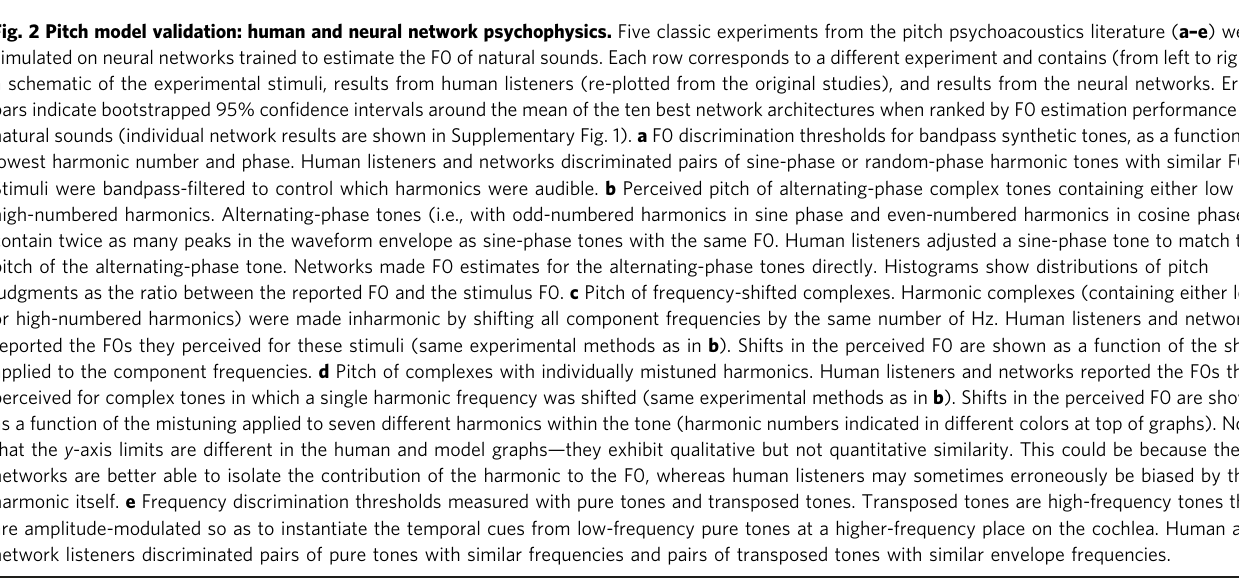
Fig. 2 Pitch model validation: human and neural network psychophysics. Five classic experiments from the pitch psychoacoustics literature ( a – e ) were simulated on neural networks trained to estimate the F0 of natural sounds. Each row corresponds to a different experiment and contains (from left to right) a schematic of the experimental stimuli, results from human listeners (re-plotted from the original studies), and results from the neural networks. Error bars indicate bootstrapped 95% con fi dence intervals around the mean of the ten best network architectures when ranked by F0 estimation performance on natural sounds (individual network results are shown in Supplementary Fig. 1). a F0 discrimination thresholds for bandpass synthetic tones, as a function of lowest harmonic number and phase. Human listeners and networks discriminated pairs of sine-phase or random-phase harmonic tones with similar F0s. Stimuli were bandpass- fi ltered to control which harmonics were audible. b Perceived pitch of alternating-phase complex tones containing either low or high-numbered harmonics. Alternating-phase tones (i.e., with odd-numbered harmonics in sine phase and even-numbered harmonics in cosine phase) contain twice as many peaks in the waveform envelope as sine-phase tones with the same F0. Human listeners adjusted a sine-phase tone to match the pitch of the alternating-phase tone. Networks made F0 estimates for the alternating-phase tones directly. Histograms show distributions of pitch judgments as the ratio between the reported F0 and the stimulus F0. c Pitch of frequency-shifted complexes. Harmonic complexes (containing either low or high-numbered harmonics) were made inharmonic by shifting all component frequencies by the same number of Hz. Human listeners and networks reported the F0s they perceived for these stimuli (same experimental methods as in b ). Shifts in the perceived F0 are shown as a function of the shift applied to the component frequencies. d Pitch of complexes with individually mistuned harmonics. Human listeners and networks reported the F0s they perceived for complex tones in which a single harmonic frequency was shifted (same experimental methods as in b ). Shifts in the perceived F0 are shown as a function of the mistuning applied to seven different harmonics within the tone (harmonic numbers indicated in different colors at top of graphs). Note that the y -axis limits are different in the human and model graphs — they exhibit qualitative but not quantitative similarity. This could be because the networks are better able to isolate the contribution of the harmonic to the F0, whereas human listeners may sometimes erroneously be biased by the harmonic itself. e Frequency discrimination thresholds measured with pure tones and transposed tones. Transposed tones are high-frequency tones that are amplitude-modulated so as to instantiate the temporal cues from low-frequency pure tones at a higher-frequency place on the cochlea. Human and network listeners discriminated pairs of pure tones with similar frequencies and pairs of transposed tones with similar